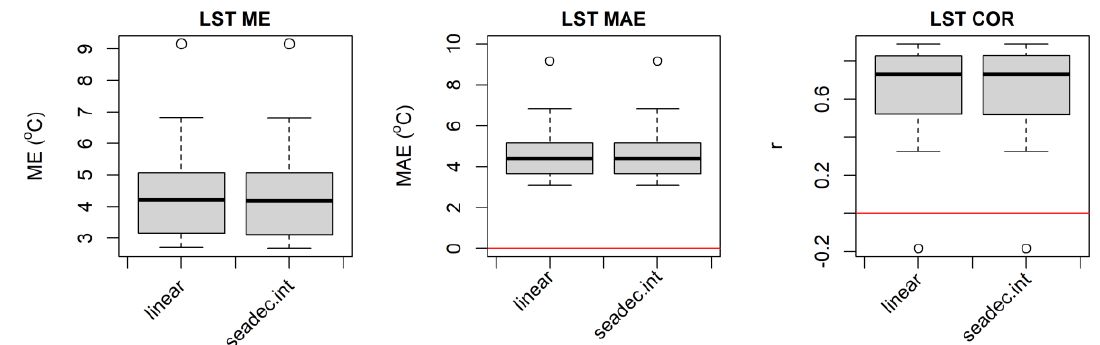
Figure 5. Daily MODIS LST comparative accuracy statistics box plots from two missing data imputation methods (linear and seasonal decomposition with interpolation algorithm) for 22 meteorological stations in the Amhara Region, Ethiopia for 2003–2016.